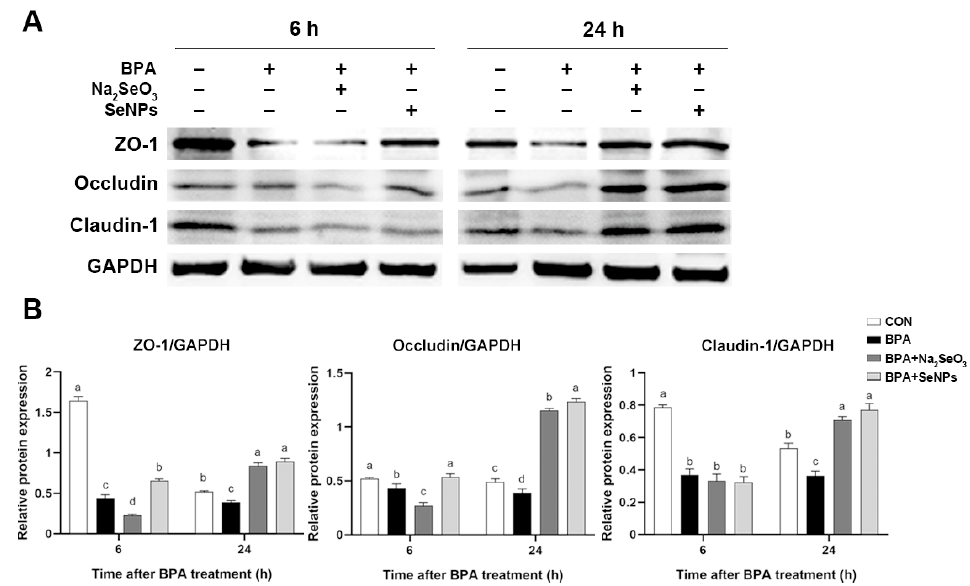
Figure 3. The effects of Na 2 SeO 3 and SeNPs treatment on the TJ expression of IPEC-J2 cells after BPA exposure. Representative panels showing expression of ZO-1, Occludin, and Claudin-1 proteins by Na 2 SeO 3 or SeNPs treatment followed by BPA exposure at 6 and 24 h ( A ). Expression of GAPDH was measured as an internal control. Results are presented as the ratio of ZO-1, Occludin, and Claudin-1 band intensity to that of GAPDH ( B ). Data are presented as the means ± SEM of three independent experiments. a,b,c,d Mean values within a row with different superscript letters were significantly different ( p < 0.05).